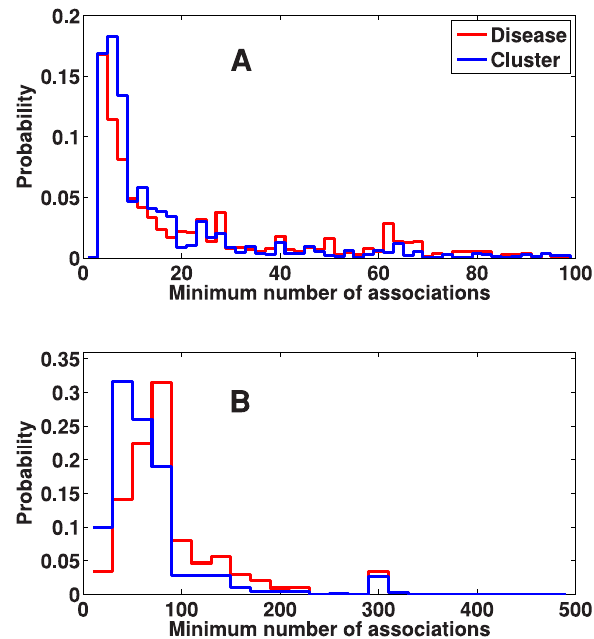
Figure 4. The effect of clustering on the minimum term size. The minimum term size distribution of (A) GO and (B) KEGG terms reported by SaddleSum enrichment analyses when using disease weight vectors directly (red curves) and when using cluster center vectors (blue curves). Not only the most informative (smallest size) terms are preserved during clustering, the clustering procedure seems to shift the minimum term size distribution towards the small end, indicating the likelihood of providing even more specific terms when weight vectors are grouped under the proposed clustering procedure.